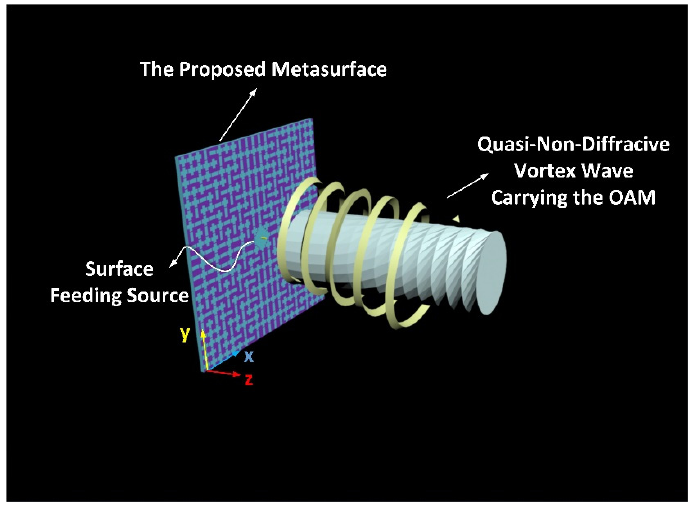
Figure 1. Scheme of a monopole-integrated holographic metasurface generating a quasi-non-diffractive vortex wave carrying the desired OAM mode.